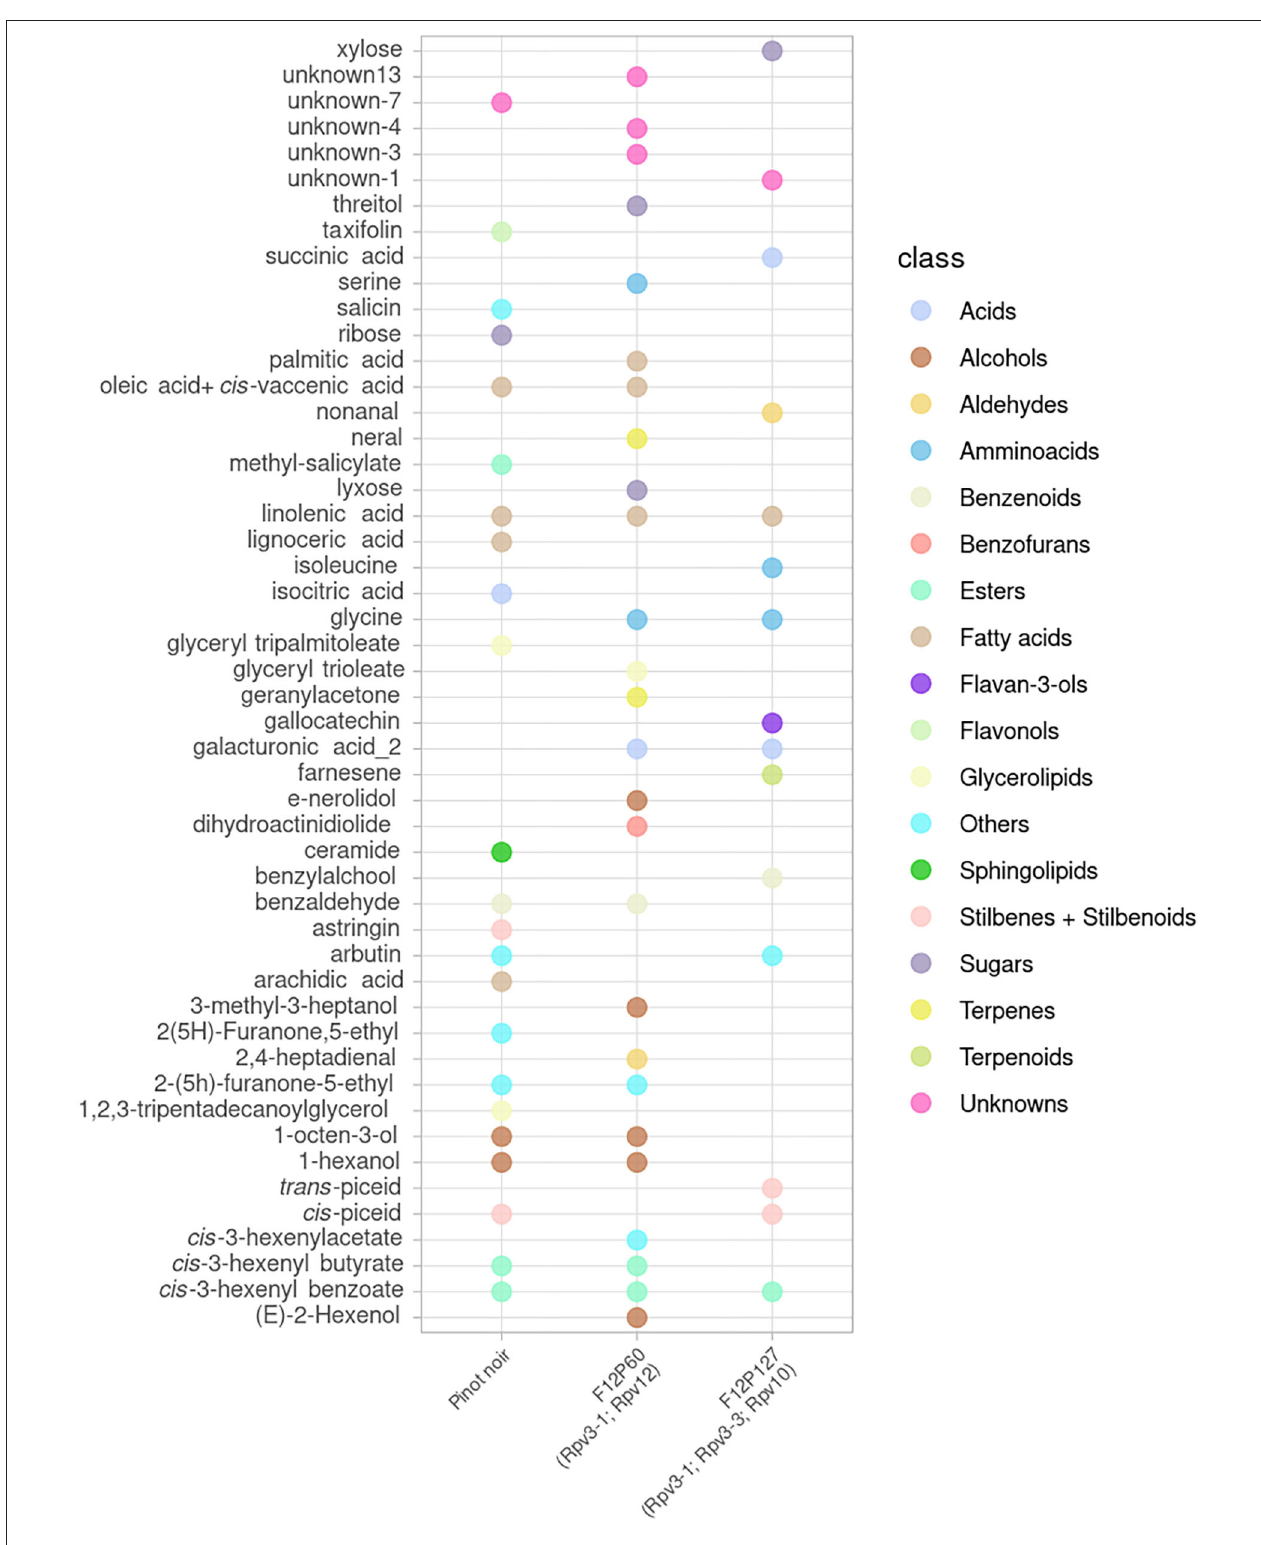
FIGURE 3 | Metabolites significantly modulated by the infection in at least one time point for the pyramided resistant genotypes (F12P60, F12P127) and for the susceptible Pinot Noir. All time points were considered in the 2 years of data analysis (2017–2018) and the color of each metabolite identifies the different chemical